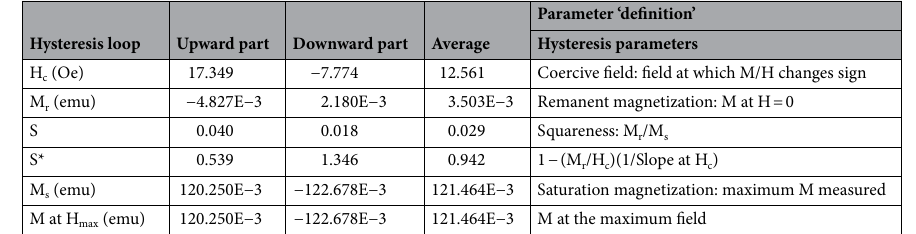
Table 2. Hysteresis parameters obtained for Fe@TiO 2 NPs in the emu vs Oe plot.